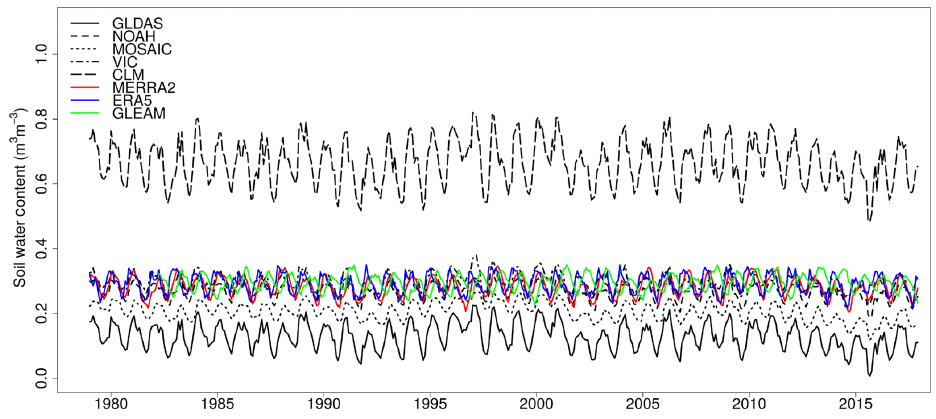
Figure 1. 1979–2017 monthly time series of mean soil moisture across all in situ data locations shown in Table 1 for multiple data products including the GLDAS multimodel mean (black, solid), MERRA2 (red, solid), ERA5 (blue, solid) and GLEAM (green, solid), as well as the individual land surface models that make up GLDAS NOAH (black, short dash), MOSAIC (black, dot), VIC (black, dash dot) and CLM (black, long dash). Note that the GLEAM time series starts in 1980. Table 1. Information on geospatial location, record length and monitoring instruments used for in situ observations that were used in the